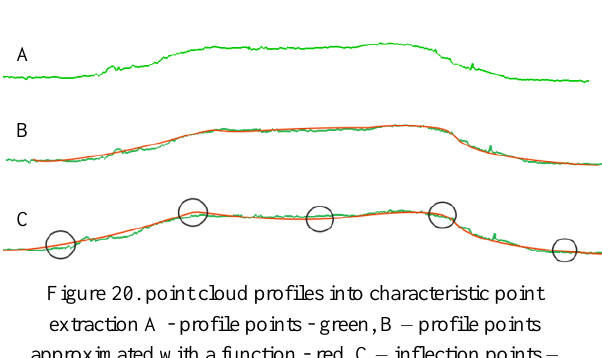
Figure 20. point cloud profiles into characteristic point extraction A - profile points - green, B – profile points approximated with a function - red, C – inflection points – black circles New inflection points represent characteristic points/features of analysed structure. These points connect into a particular type of shape - ovals (Figure 21, red dotted lines). Figure 18. Profiles A-B and C-D of suspected structure – object 4